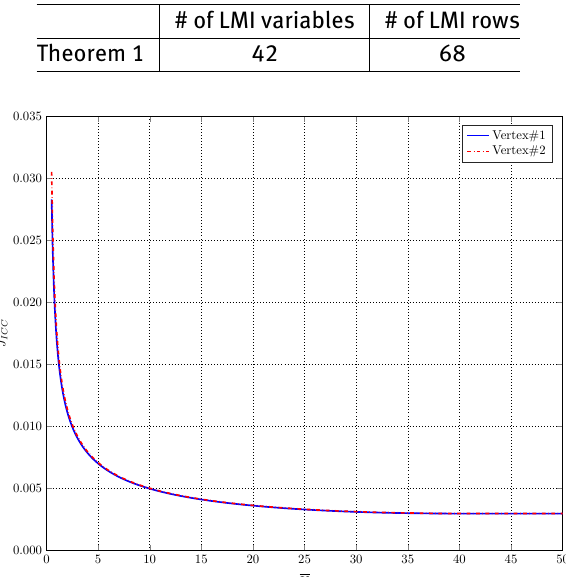
Figure 3: The ICC cost versus control constraints at vertex #1 and vertex #2